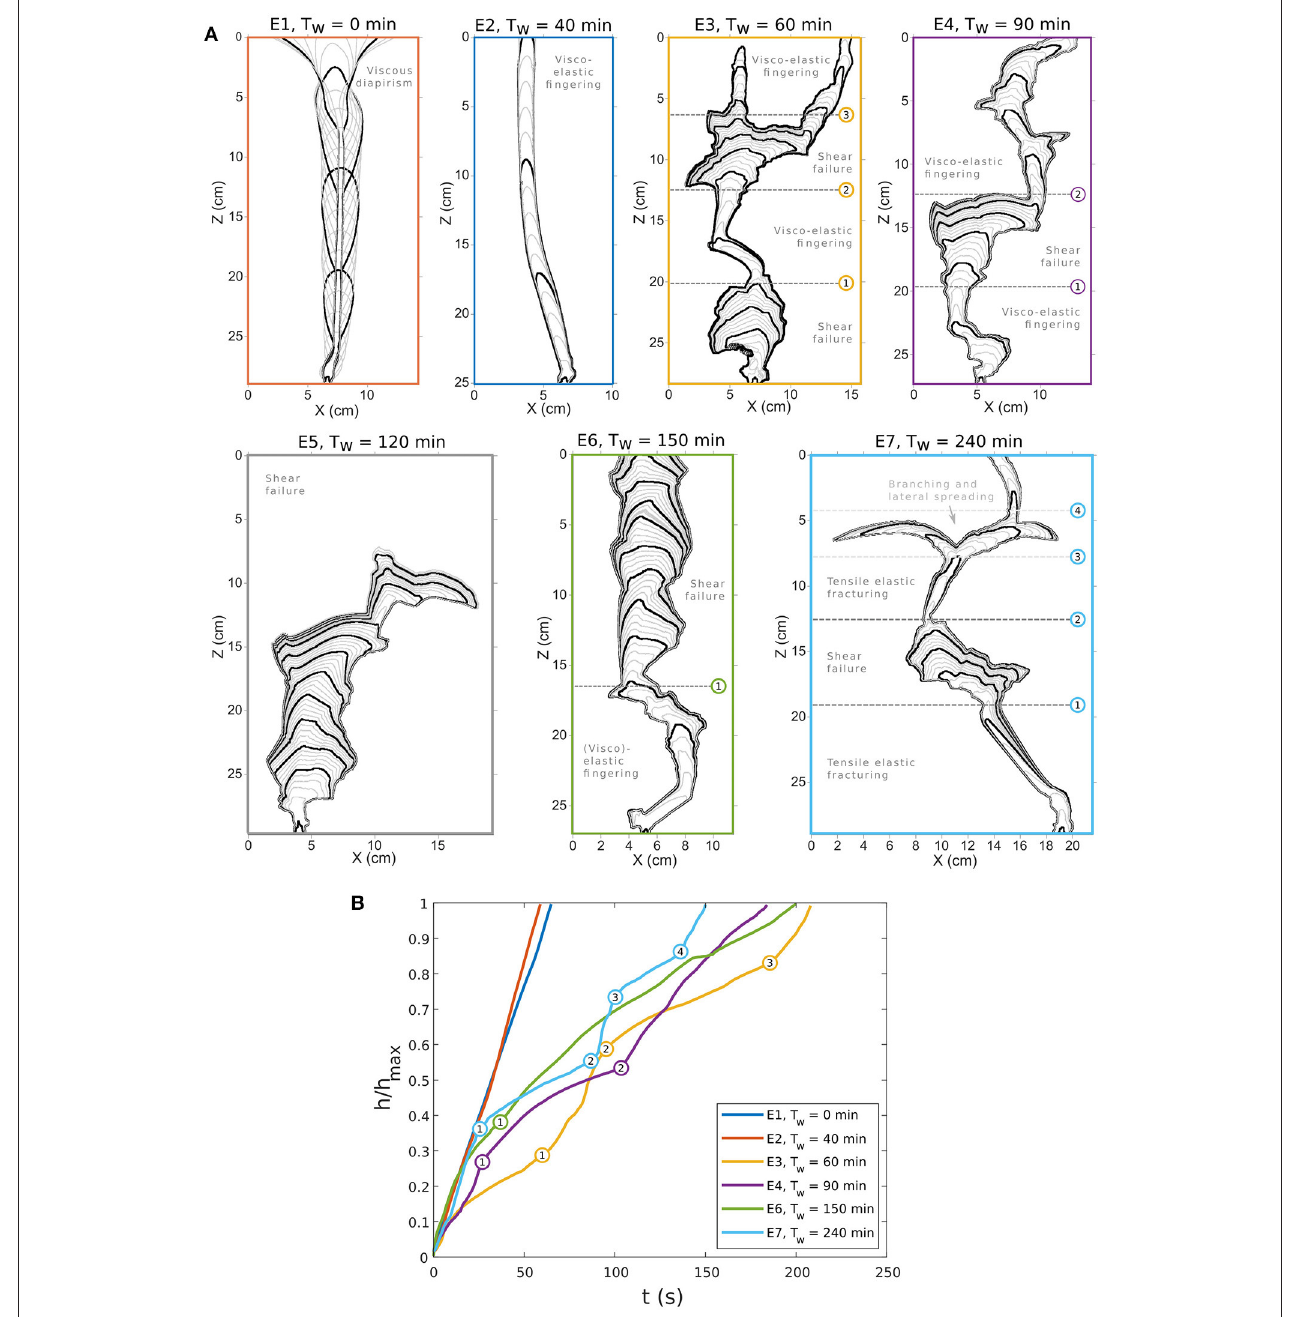
FIGURE 11 | (A) Maps of time evolutions of intrusions’ contours calculated with image analysis. The time gap between the gray contours is 4 s, while the time gap between the black contours is 20 s. Numbers indicate the position of the intrusion tips when morphological transitions occur during intrusion evolution. The labeling of the emplacement modes for the identified stages refers to interpretation in section 4.2 and in Figure 12 . (B) Plot of scaled position of the uppermost tip of the intrusions ( h / h max ) as a function of time for all experiments but E5. The numbers correspond to the morphological transitions identified on intrusion shape maps in (A) . Note that these morphological transitions coincide with sharp kinks of propagation